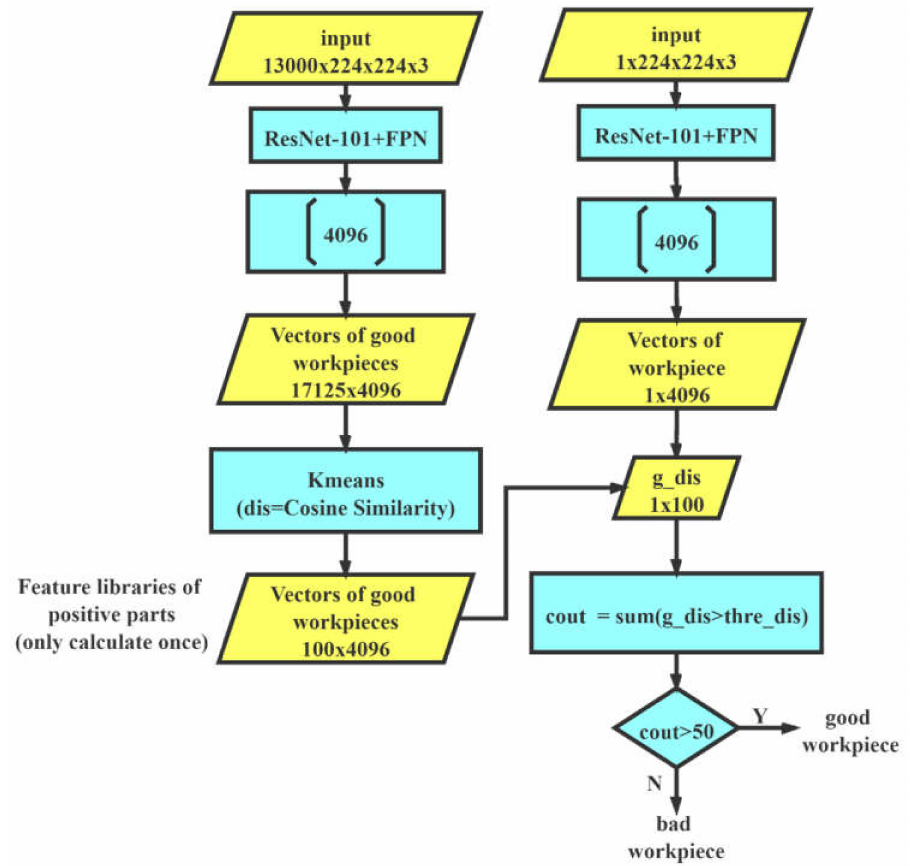
Figure 7. The method of feature library